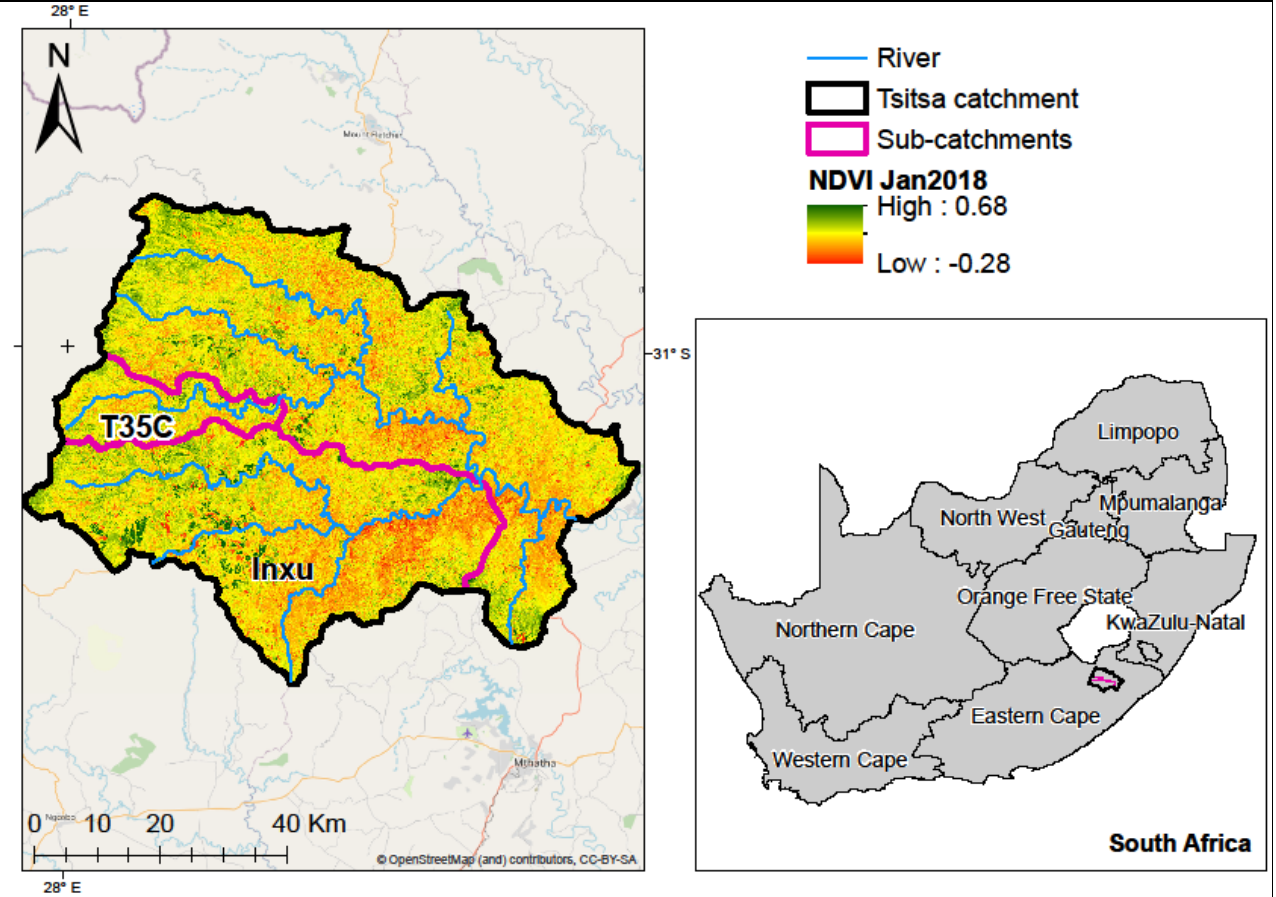
Figure 1. Map showing the location of the study area in the Eastern Cape Province, South Africa. The Inxu and T35C sub-catchments flow into the greater Tsitsa catchment. The two sub-catchments were modelled independently and as part of the entire catchment.